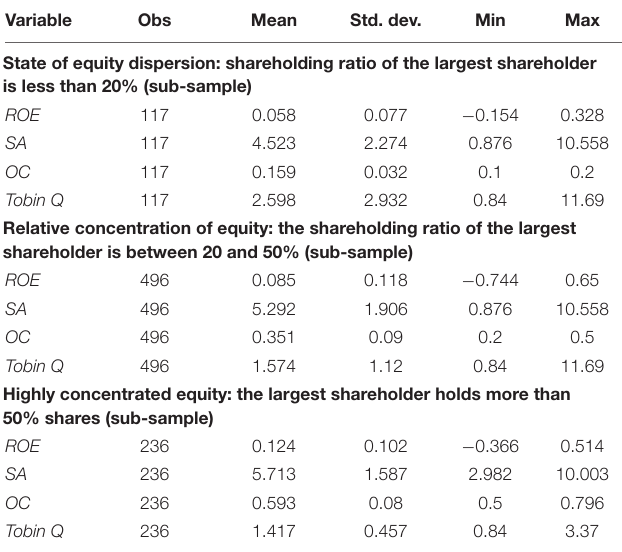
TABLE 3 | Descriptive statistical results of key indicators in the sub-sample group. Variable